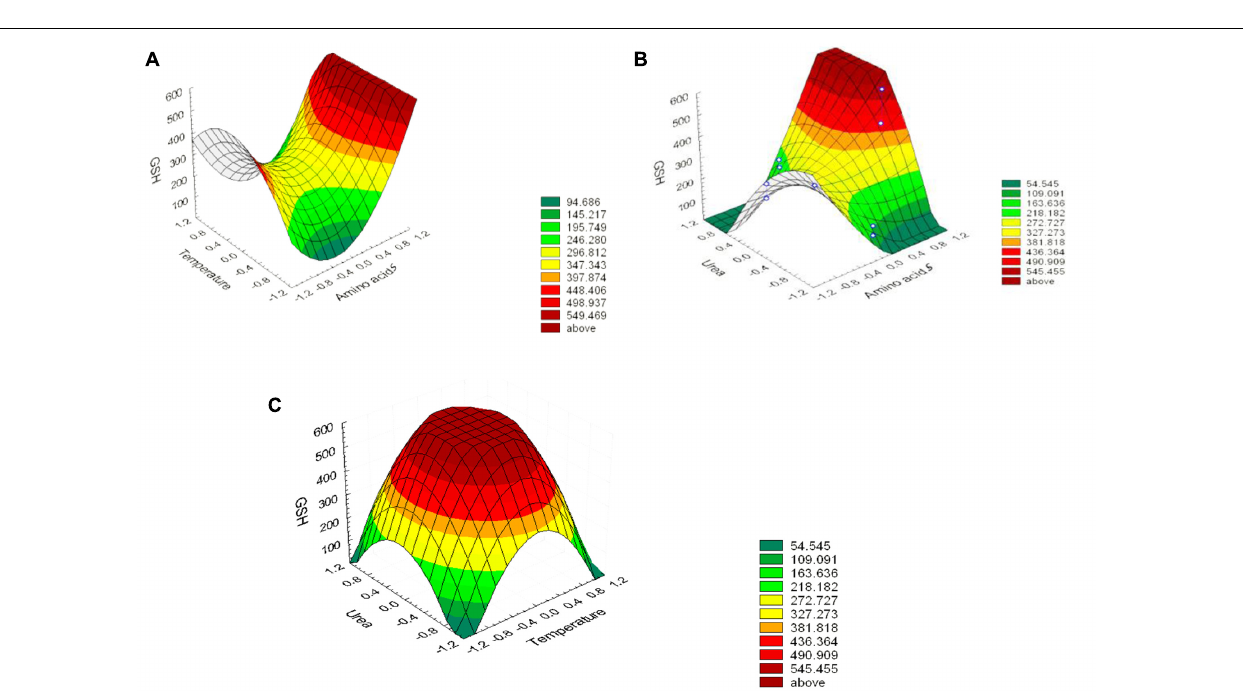
FIGURE 4 | Effect of culture conditions on the GSH production by L. plantarum isolate based on Plackett–Burman design results.